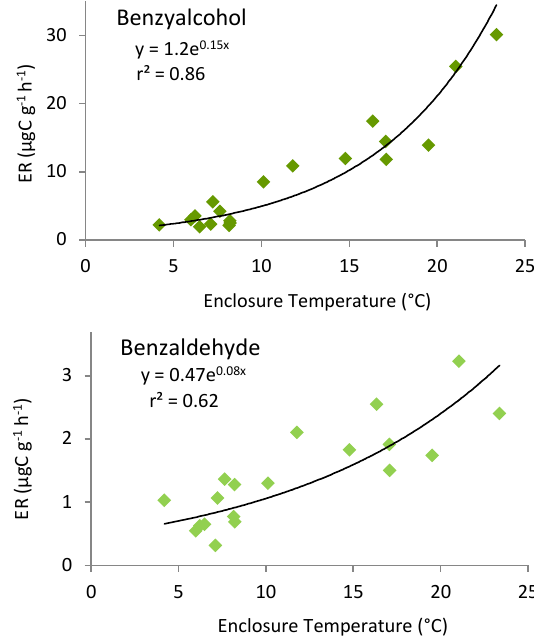
Fig. 4. Emission rates of benzyl alcohol and benzaldehyde during blooming as a function of air temperature inside the enclosure from a crabapple experiment.